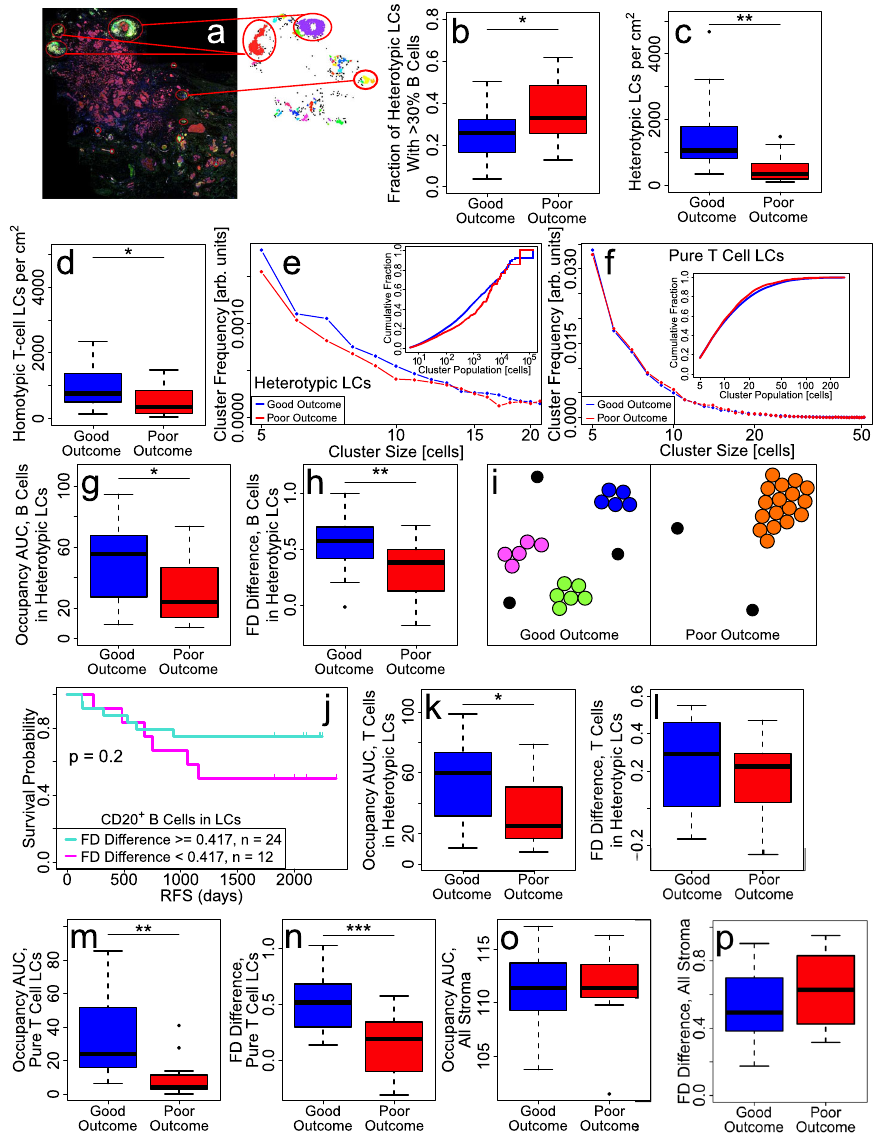
Fig. 6 LCs are smaller, more numerous, and more evenly distributed in good outcome. a Sample image showing TLS. Color code: Nuclei (DAPI, dark blue), B cells (CD20 + ; yellow), DC-LAMP (magenta), PNAd (green), and cancer cells (Pan-cytokeratin cells; red). b Fraction of heterotypic LCs with more than 30% B cells is lower for good ( n = 24) vs. poor outcome ( n = 12) tumors. Plots showing ( c ) number of heterotypic LCs per cm 2 and ( d ) number of pure T cell LCs per cm 2 are higher for good outcome. e Cluster size distribution showing heterotypic LCs are smaller and more numerous in good outcome vs. poor outcome tumors. (Inset) Cumulative fractions of lymphocytes that belong to heterotypic LCs of a given size (population) or smaller show that there are more small clusters in good outcome, and more large clusters in poor outcome, as indicated by crossing of the curves at large cluster sizes. f Cluster size distribution of pure T LCs showing no signi fi cant difference between good and poor outcome tumors (see “ Methods ” section for normalization of distributions). (Inset) Cumulative fractions of T cells that belong to pure T cell LCs of a given size (population) or smaller lack distinction between good vs. poor outcome. Plots of ( g ) occupancy AUC of B cells in heterotypic LCs and ( h ) FD difference for B cells in heterotypic LCs, indicating that B cells in heterotypic LCs are more spatially dispersed in good outcome. i Cartoon illustrating lymphocytes in LCs that are more spread out (left panel: good outcome) vs. more aggregated (right panel: poor outcome). Each color corresponds to a unique LC. Black points are isolated lymphocytes. j RFS plot showing the clinical signi fi cance of FD difference of B cells in heterotypic LCs with a threshold value of 0.417 (see “ Methods ” ). k Plot showing occupancy AUC of CD3 + T cells in heterotypic LCs is higher in good outcome. l Plot showing FD difference for CD3 + T cells in heterotypic LCs is not signi fi cantly different between good and poor outcome. Pure T cell LCs are more evenly distributed in good outcome: ( m ) occupancy AUC and ( n ) FD difference of T cells in pure T cell LCs is higher in good outcome. Spatial distribution of LCs is not attributable to the spatial distribution of stromal cells: ( o ) occupancy AUC and ( p ) FD difference of all stromal cells is not signi fi cantly different between good vs. poor outcome. Patient cohorts for all plots in this fi gure are n = 24 for good outcome (blue) and n = 12 for poor outcome (red). For all box-and- whisker plots, the center line represents the median, box limits represent the upper and lower quartiles, whiskers indicate maximum and minimum values within 1.5 interquartile ranges of the upper and lower quartiles; individual points are outliers. P -values in box plots are determined by unpaired, two-tailed Student t -tests. ns: not signi fi cant; * p < 0.05; ** p < 0.01; *** p < 0.001; **** p < 1 × 10 − 4 .